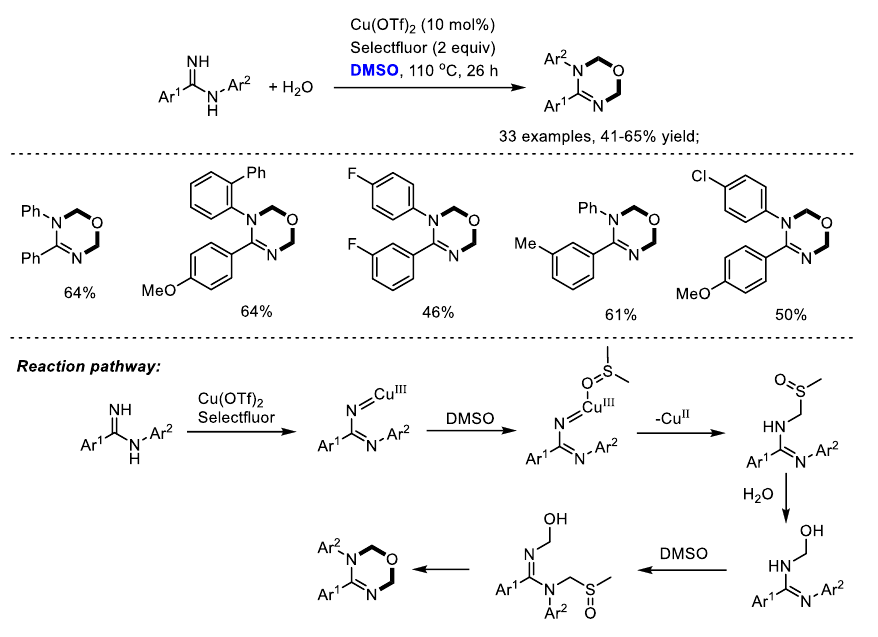
Scheme 17. DMSO-based synthesis of isoindolinones